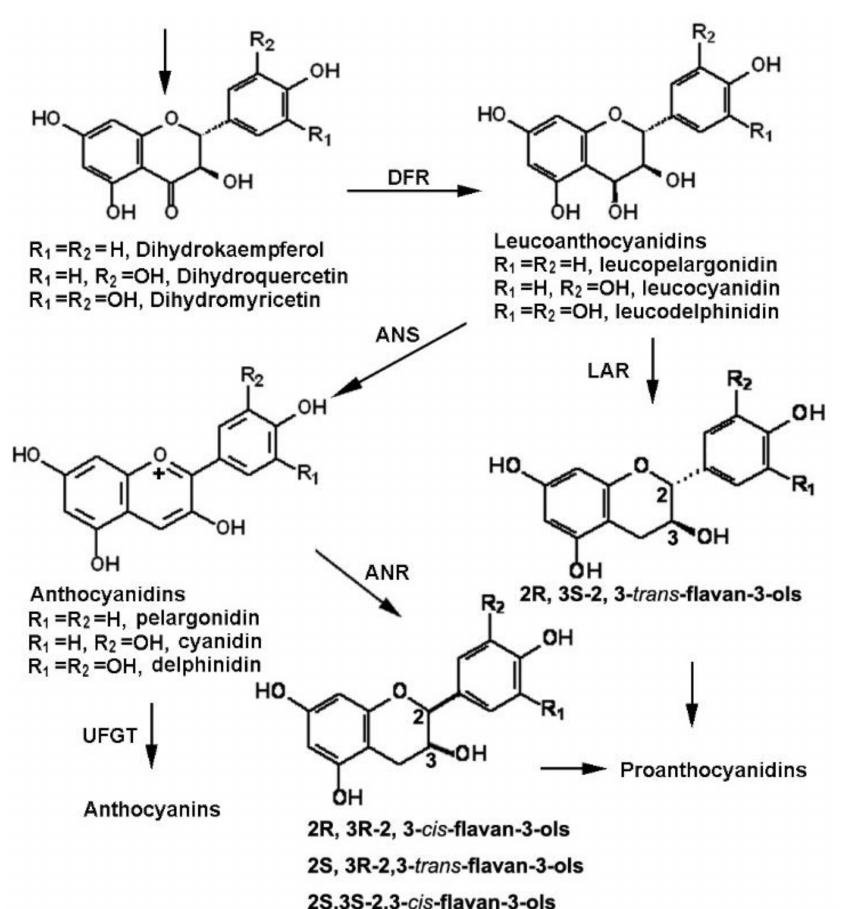
Figure 1. Late pathway steps of flavonoids from dihydroflavonol to anthocyanins and proanthocyanidins. DFR: dihydroflavonol reductase, ANS: anthocyanidin synthase, ANR: anthocyanidin reductase, LAR: leucoanthocyanidin reductase, and UFGT: UDP-glucose flavonoid 3- O -glucosyltransferase. UDP: uridine